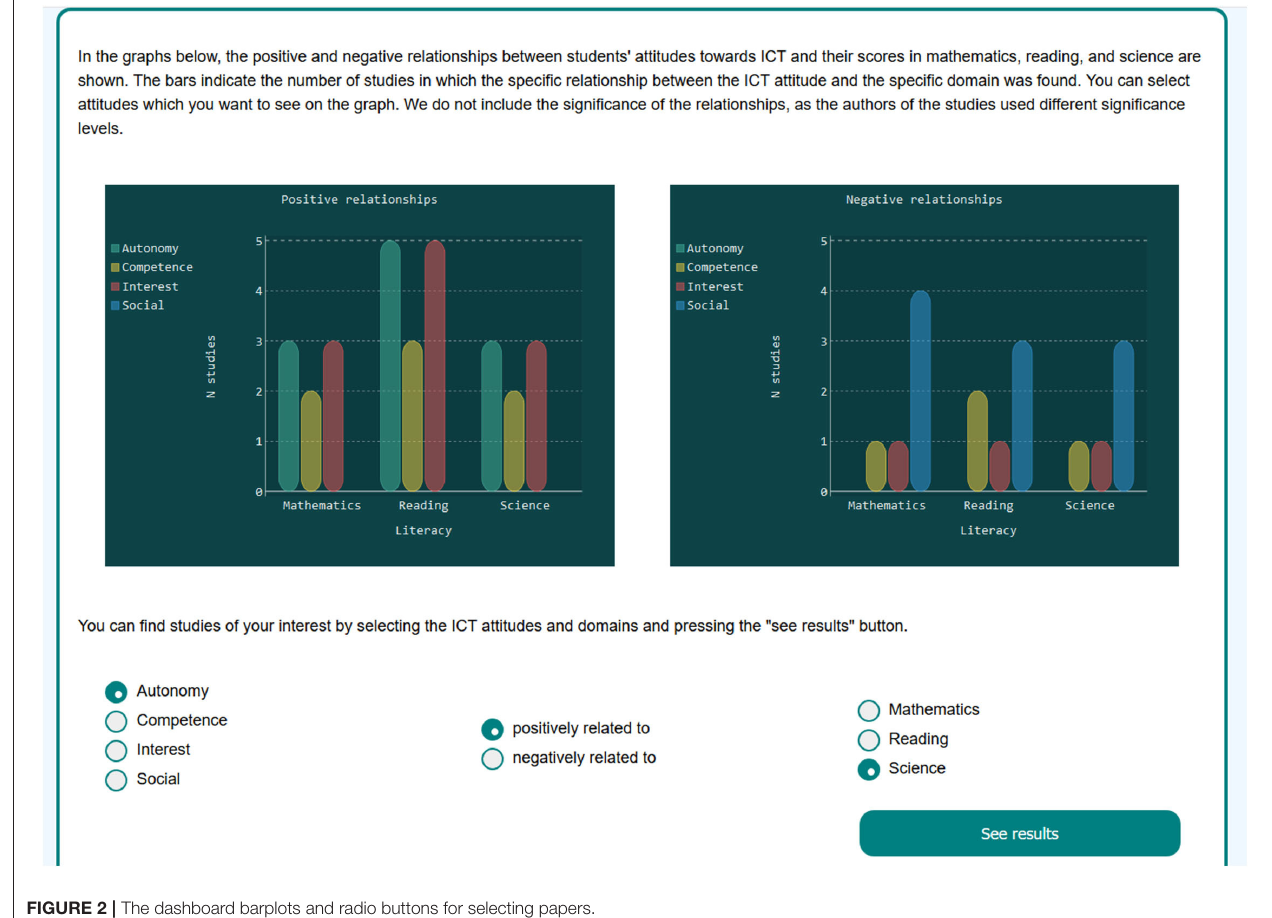
FIGURE 2 | The dashboard barplots and radio buttons for selecting